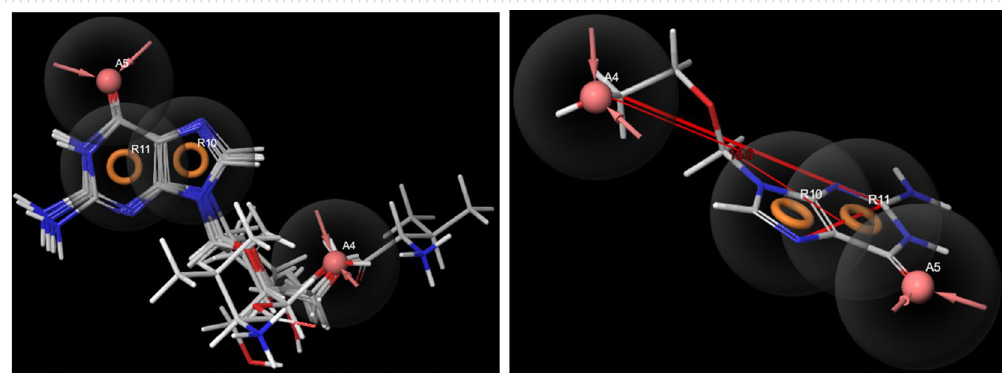
Figure 6. ( a ) The pharmacophore model (AARR) for guanine derivatives, ( b ) the dihedral angle between the guanine ring plane and the plane containing acceptor oxygen(A4) (generated by Maestro 11.2 GUI) 36